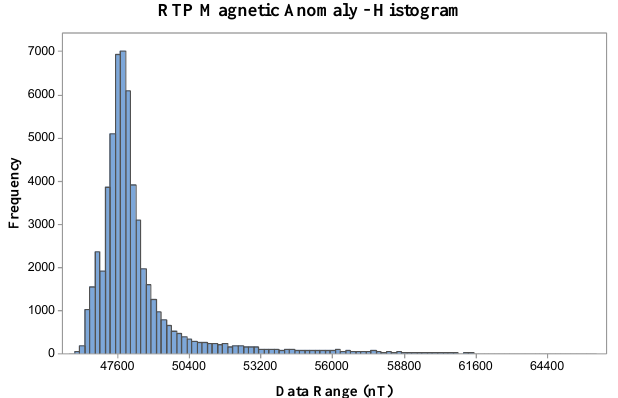
Figure 5. Gaussian curve based on the RTP magnetic anomaly his- togram in